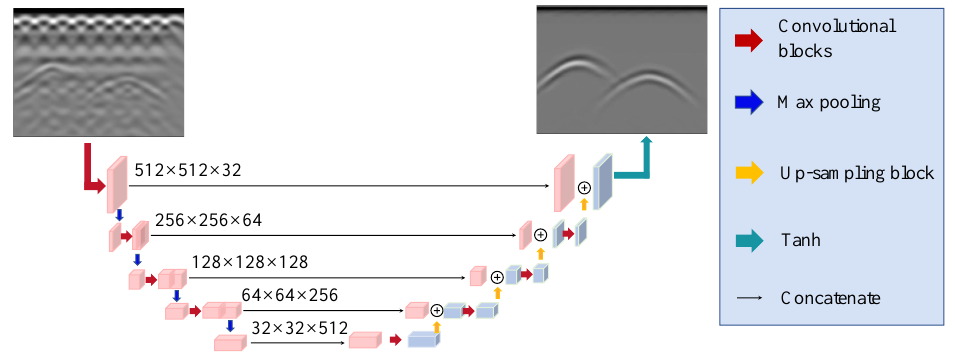
Figure 5. Architecture of the deep learning network for rebar clutter